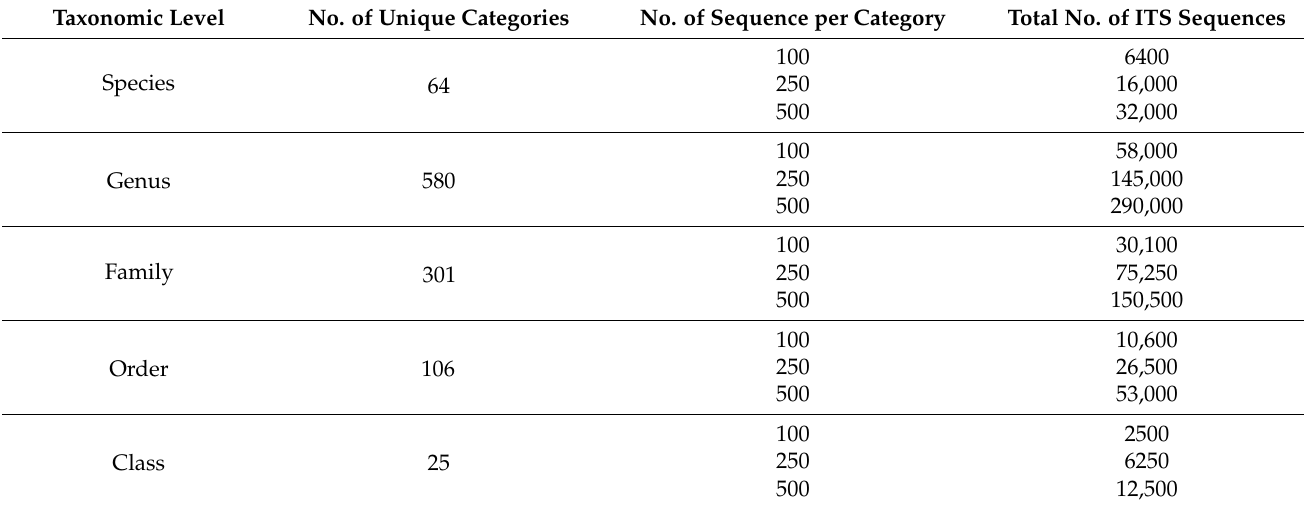
Table 3. Balanced datasets of ITS sequences with invariant category numbers for different taxonomic levels (from Species to Class